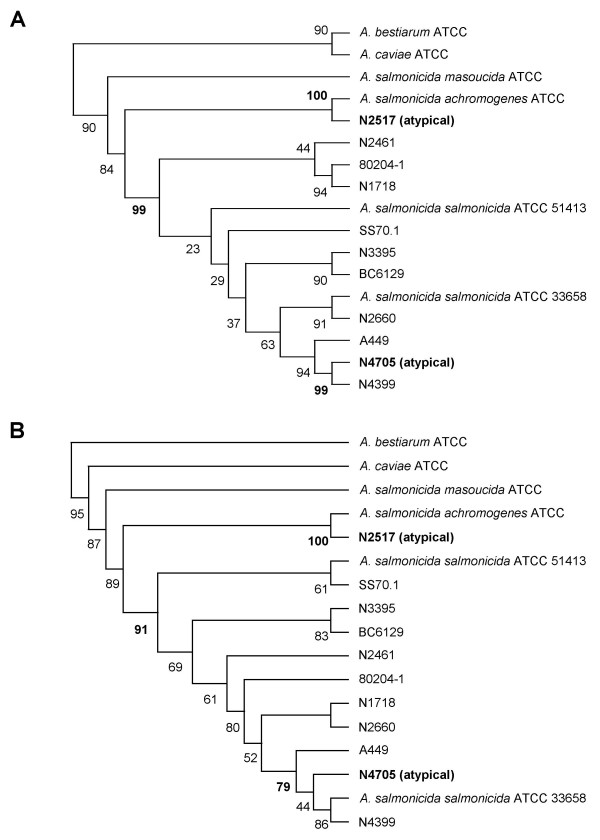
Hierarchical clustering of Aeromonas strains based on M-CGH data for all genes on the microarray. The dendrogram was produced using the MEV software from TIGR with Euclidean distance and average linkage clustering (n = 1,000 bootstrap iterations). Isolates in bold are atypical isolates that cluster with other known subspecies. The bootstrap values which lead to their cluster assignment are also in bold. All ATCC type strains are denoted "ATCC", and unless otherwise noted, all other isolates are A. salmonicida subsp. salmonicida. (A) Sample clustering based on all genes on the AsalChip1 microarray. (B) Sample clustering based on genes not assigned to the plasmid or transposon functional categories (i.e. "chromosomal" genes).